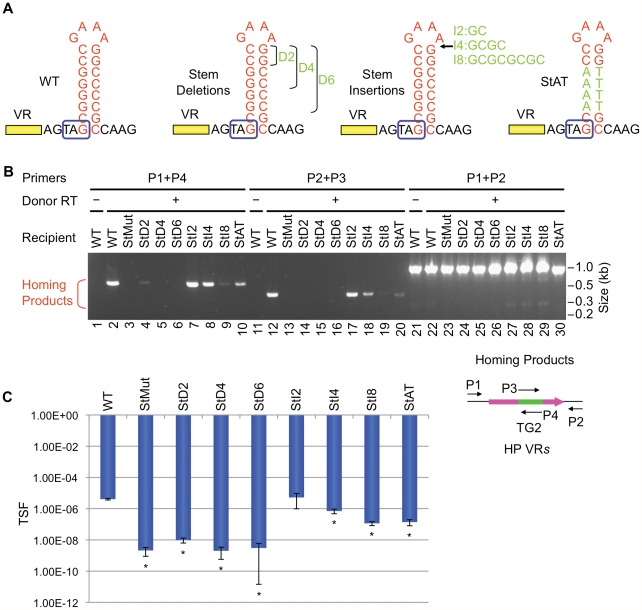
The stem length and sequence are important but can tolerate minor modifications.(A) Modifications in the stem of the hairpin/cruciform structure are shown. StD2, StD4 and StD6 are deletion mutants; StI2, StI4 and StI8 are insertion mutants. StAT has four GC base pairs in the middle of the stem changed to AT base pairs. Boxed TAG, mtd stop codon. (B) The stem is important for BPP-1 DGR mutagenic homing but can tolerate minor changes. PCR-homing assays are shown along with primers used. (C) Effects of stem modifications on phage tropism switching frequencies. The scale bars represent mean TSF ± s.d. P values comparing mutants to WT in Student's t tests are indicated with asterisks. *P<0.02.